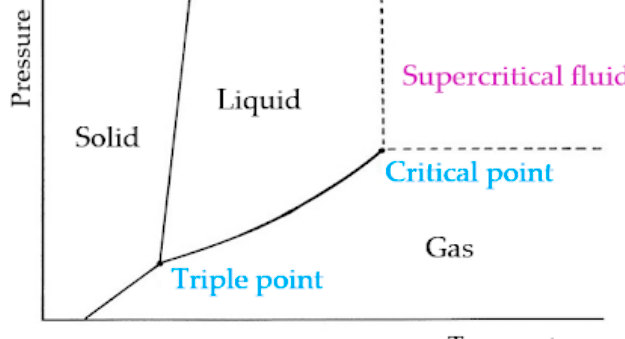
Figure 12. Pressure–temperature phase diagram.